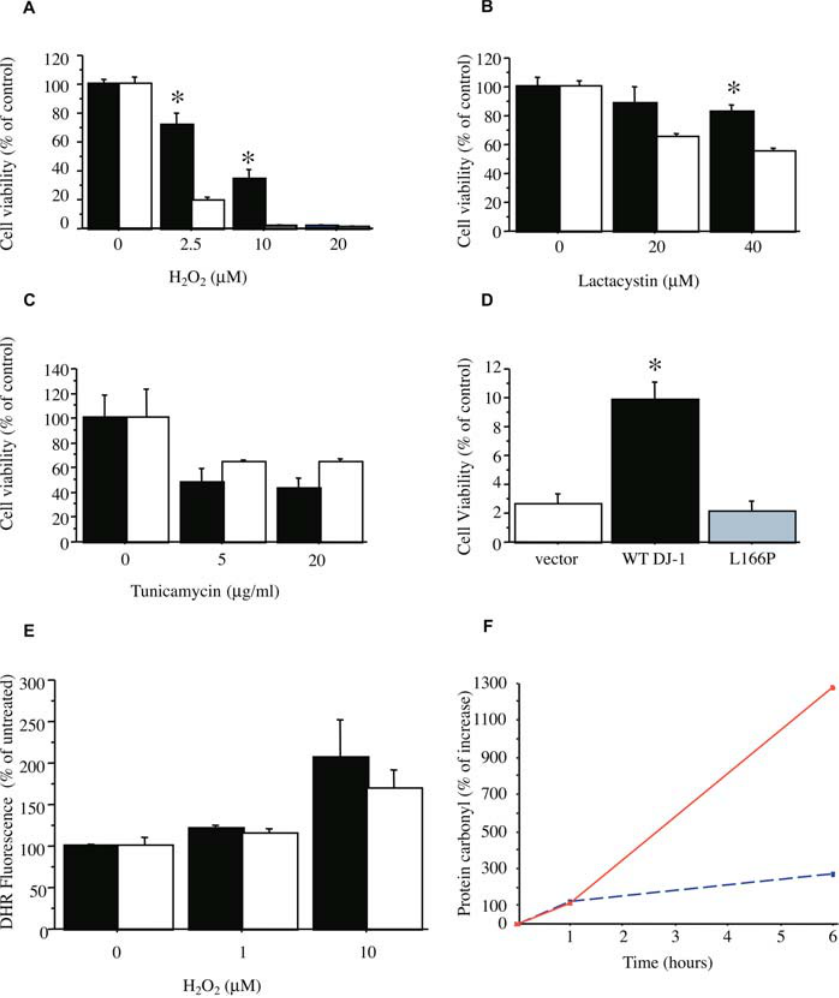
(E) DJ-1-deficient cells (clone 32; open bar) and control heterozygous cells